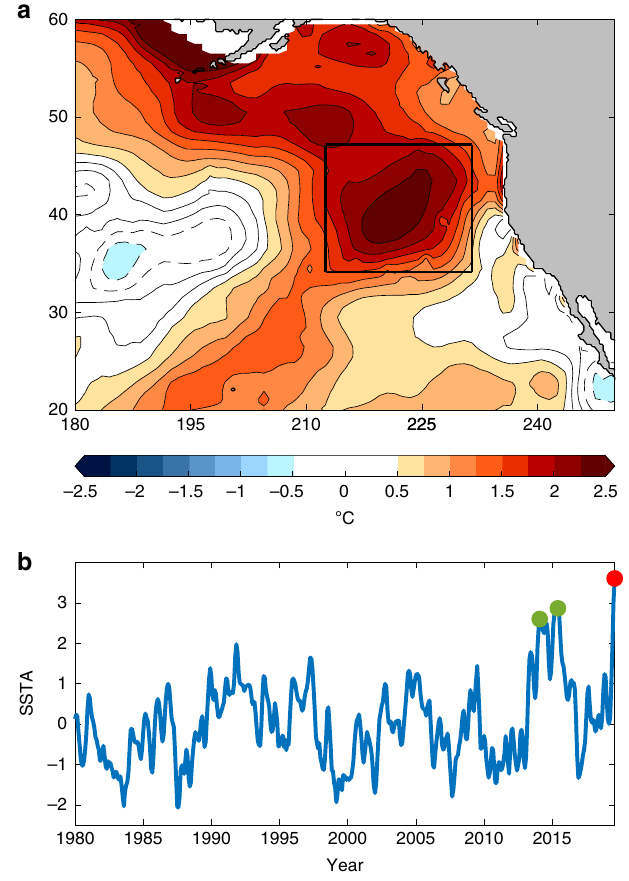
Fig. 1 The Blob 2.0 in an ocean reanalysis product. a Five-meter ocean temperature anomalies (°C) averaged for June – August (JJA) 2019 in Global Ocean Data Assimilation System (GODAS). b Time series of normalized monthly mean sea surface temperature anomalies area- weighted averaged in black box above, smoothed with a 3-month running mean for the period 1980 – 2019. Red dot marks JJA 2019. Green dots mark the two peaks of Blob 1.0 averaged in January – March 2014 and May – July 2015,